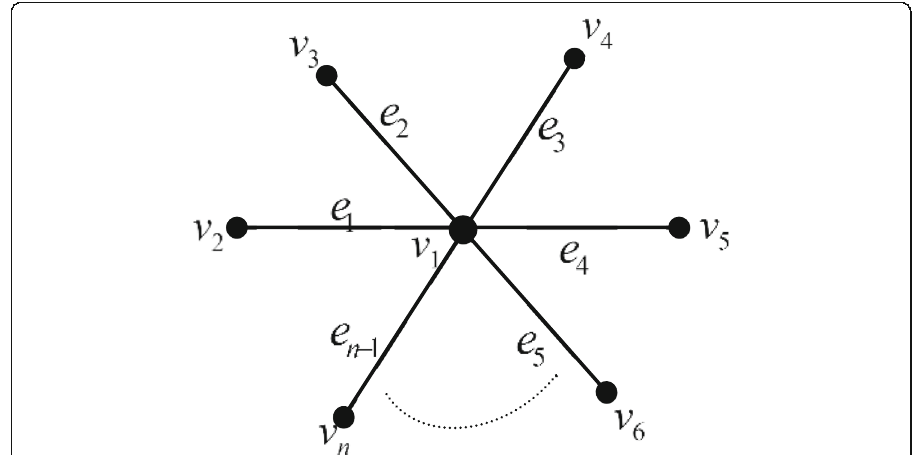
Fig. 3 A cycle graph C